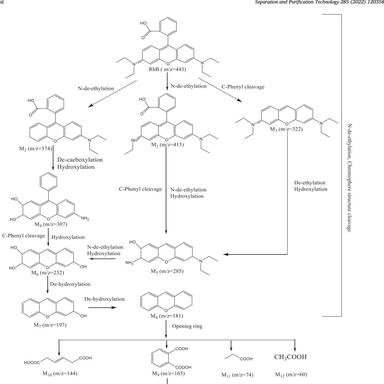
Proposed mechanism for decomposition of RhB in water using NiCoFe-LDO material for PMS activation.